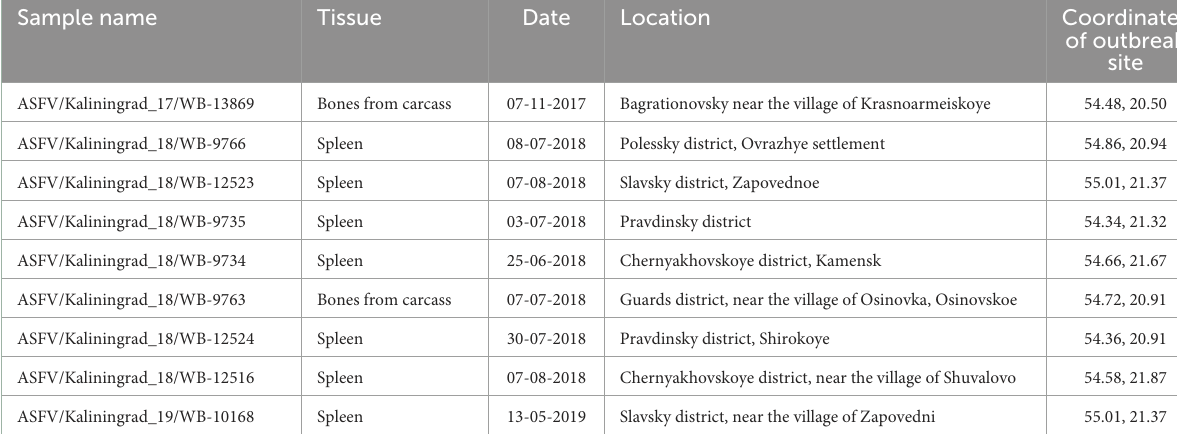
TABLE 1 Brief characteristics of the ASFV strains used in this